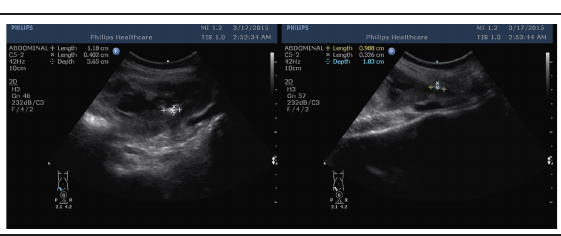
Figure 2. Recurrence of urolithiasis occured both in the kidney and ureter.